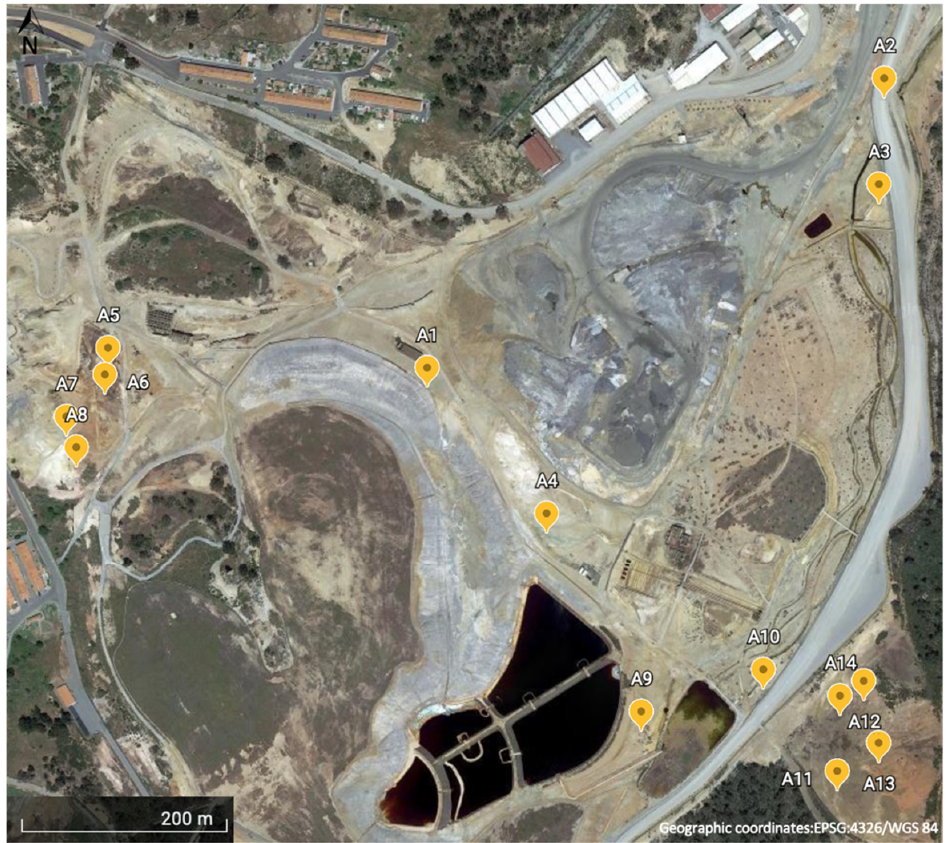
Figure 2. Google Earth image (24 May 2022) evidencing the sampling sites at the Aljustrel mine area, covering an area already rehabilitated by EDM [5]. A1 and A4: sites near the confined waste materials, Algares area; A2 and A3: sites near the perimetral channels that collect drainage waters; A5–A8: area near recent tailing deposits; A9–A10: soils with scarce vegetation, but eventually representative of natural soils; and A11–A14: soils near old tailing deposits.